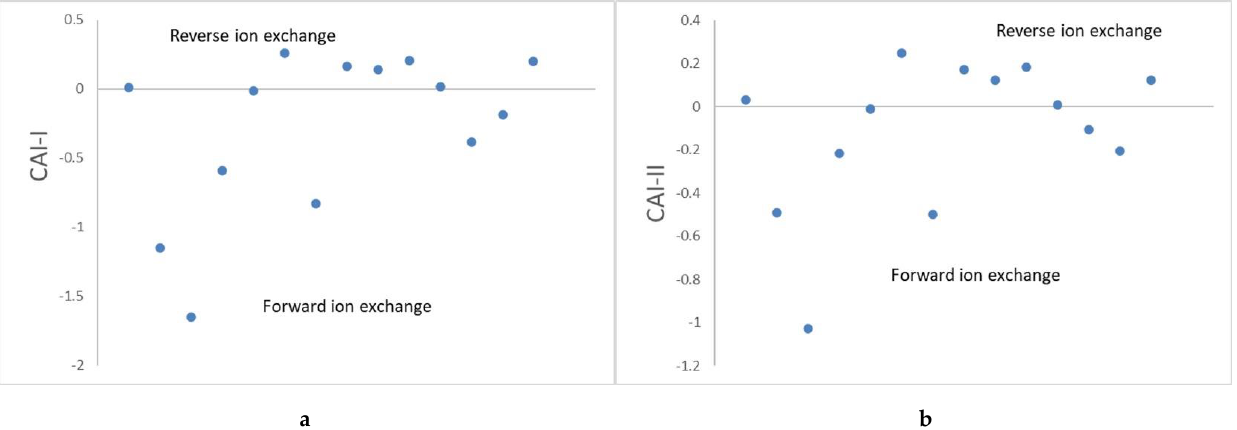
Figure 7. Schoeller [33] ( a ) CAI-I and ( b ) CAI-II plots of water collected in the Soutpansberg region.